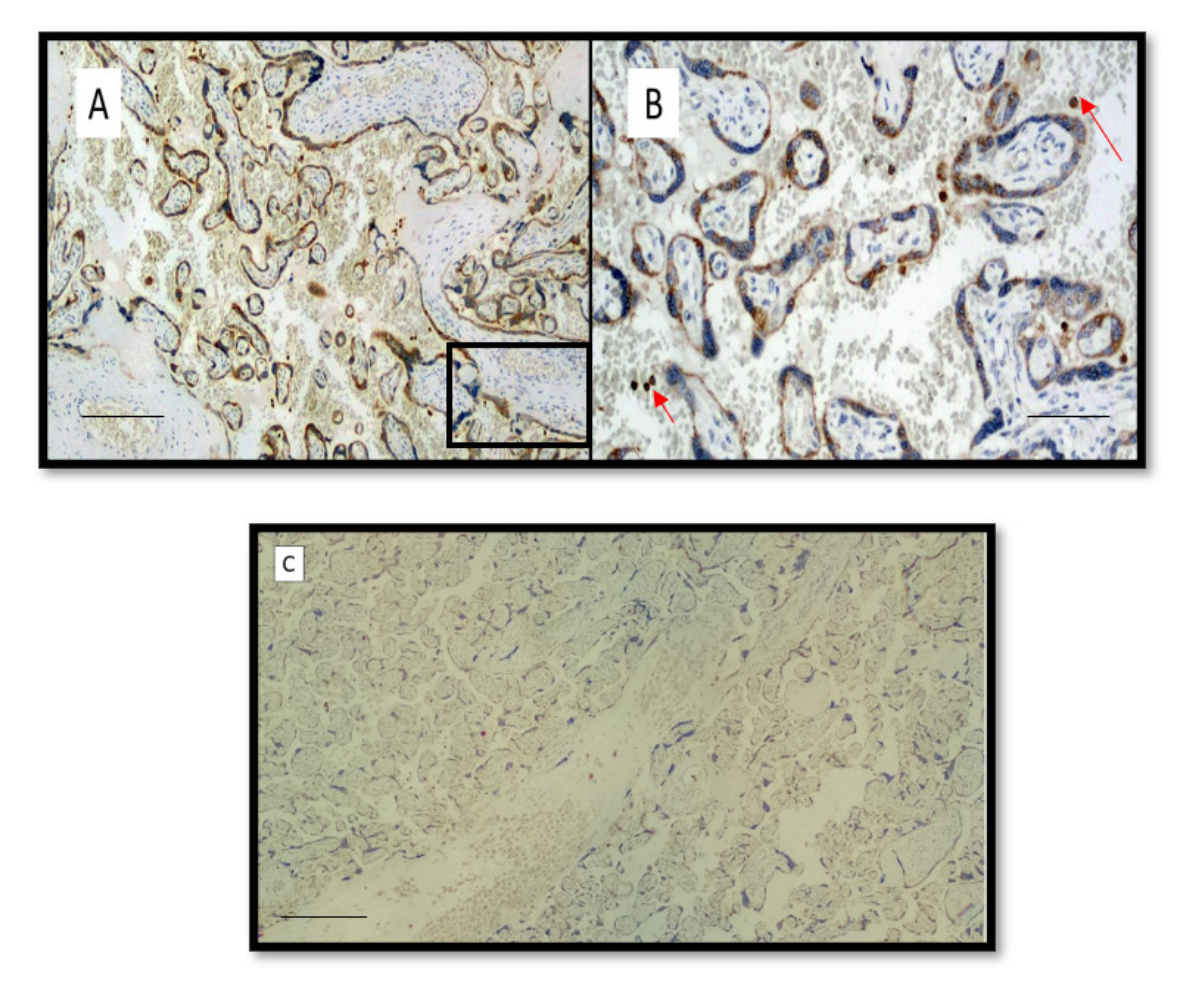
Figure 1. ( A ) Preparation for immunostaining with anti-SARS-CoV-2 S1 spike protein antibody in placentae from intensive care mothers (Immunohistochemistry, Original Magnification: 4×, scale bar: 700 µm). ( B ) Detail of box of previous picture of anti-SARS-CoV-2 S1 spike protein positivity (Immunohistochemistry, Original Magnification: 20×, scale bar: 350 µm) (red arrows indicate SARS- CoV-2-positive histiocytes). ( C ) Immunohistochemical negative control of a placenta from a negative SARS-CoV-2 mother (Immunohistochemistry, Original Magnification 4×, scale bar: 800 µm).